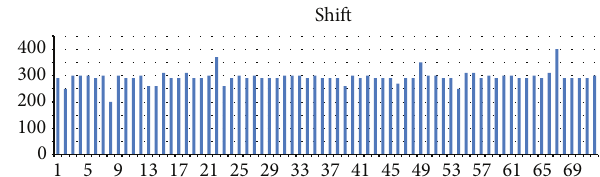
Figure 6: Value of “shift” that adjusts the old baseline wander to form the new one for all 72 subjects.